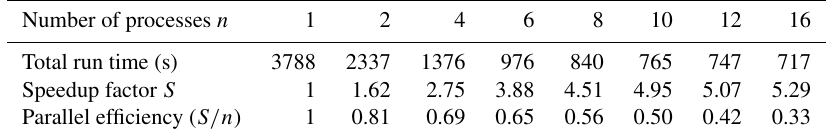
Table 6. Run time and speedup using up to 16 cores on a machine equipped with an AMD Opteron 6386 SE processor (900000 particles). Number of processes